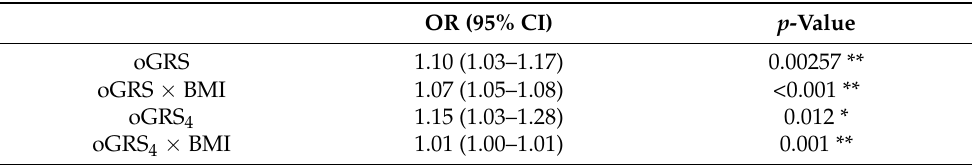
Table 3. Results of multivariate logistic regression analyses of optimized genetic risk score (oGRS) and oGRS 4 separately and in combination with BMI (as an interaction variable) on the risk of metabolically unhealthy